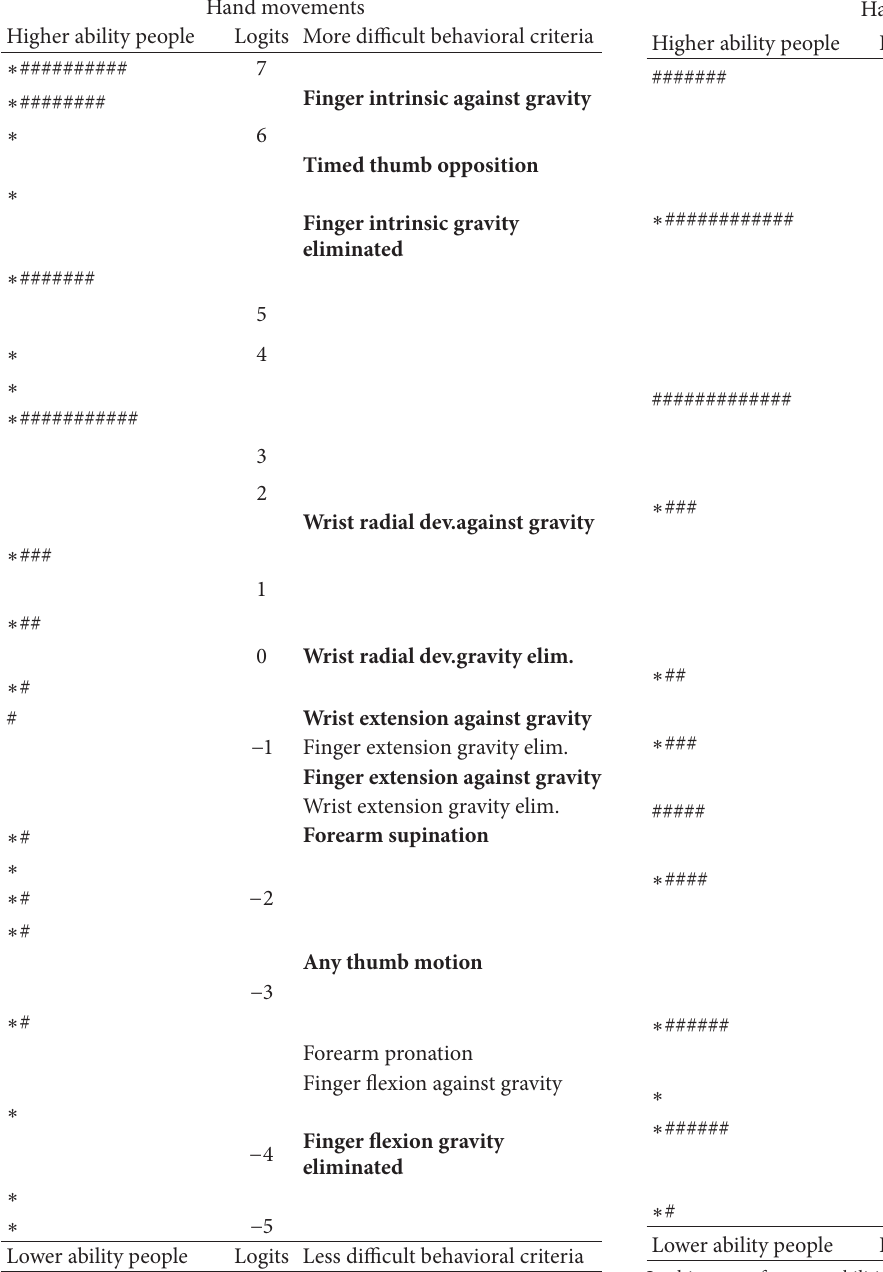
Table 4: Person-behavioral criteria map for